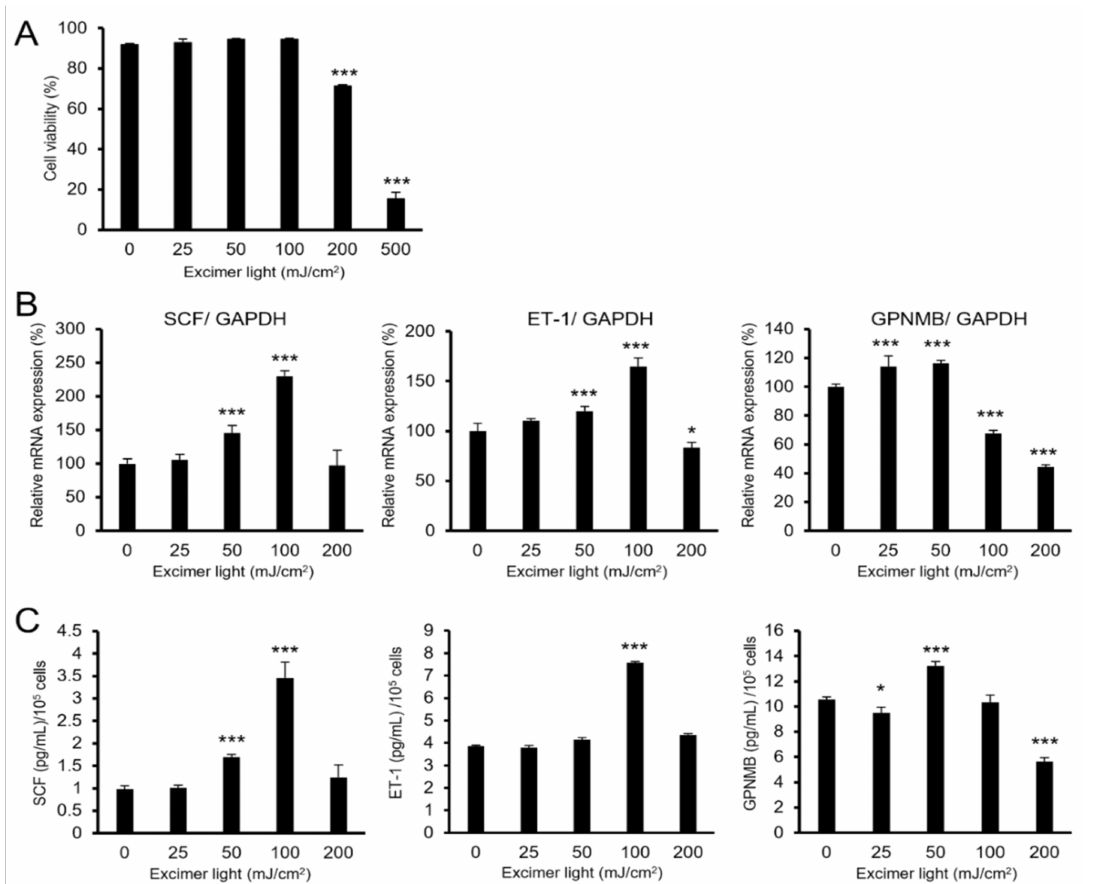
Figure 1. Monochromatic excimer light (MEL) irradiation with a nontoxic dose induced stem cell factor (SCF), endothelin- 1 (ET-1), and glycoprotein nonmetastatic melanoma protein B (GPNMB) in PSVK1 keratinocytes. ( A ) Cell viability of PSVK1 keratinocytes after 24 h radiation with the indicated dose of MEL. ( B ) Relative mRNA expression of SCF, ET-1, and GPNMB after 24 h of irradiation with the indicated dose of MEL. ( C ) Protein expressions of SCF, ET-1, and GPNMB in cultured supernatants using an ELISA assay after 48 h of irradiation with the indicated dose of MEL. Data are shown as the means ± SD, * p < 0.05; *** p < 0.01; one-way analysis of variance followed by Dunnett’s test vs. 0 mJ/cm 2